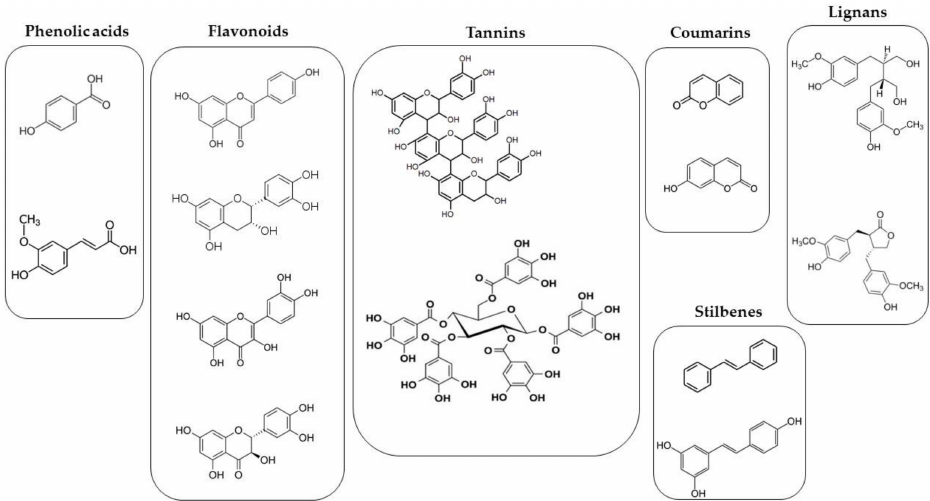
Figure 4. Examples of phenolic compounds structures presents in plant extracts (https://chem.nlm. nih.gov/chemidplus/, accessed on 10 November